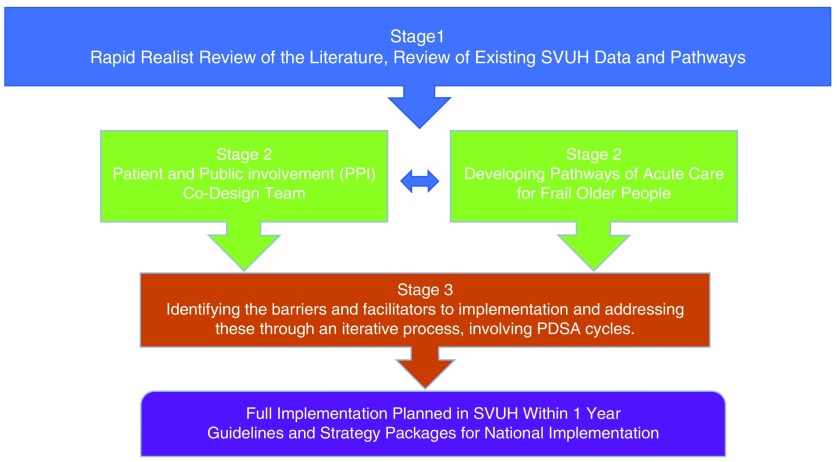
SAFE research plan.